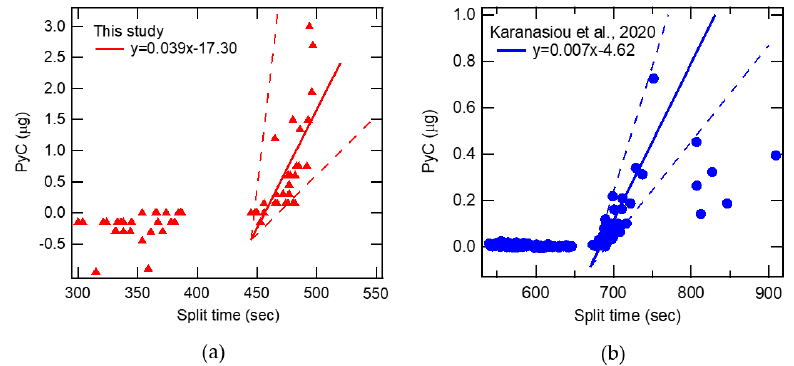
Figure 7. PyC quantity as a function of split time: ( a ) This study; ( b ) Other study [25].